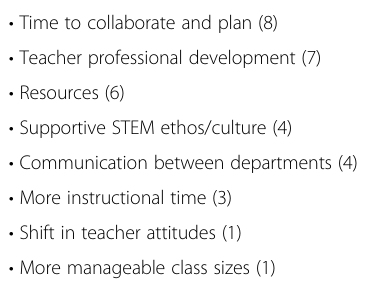
Challenges to achieving integrated STEM